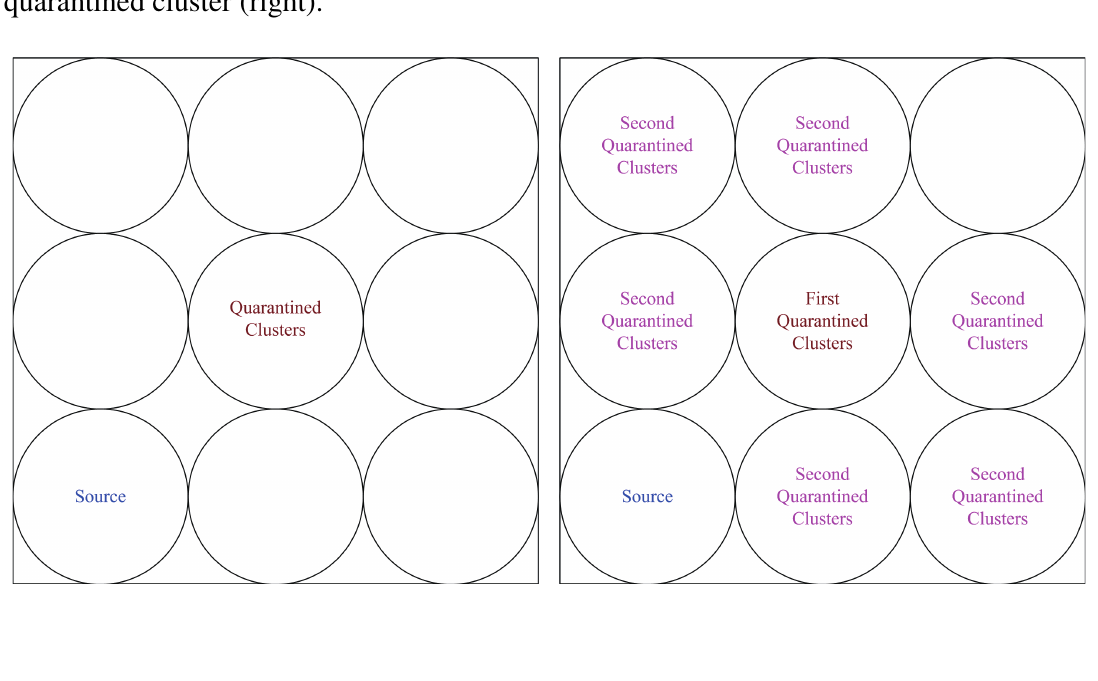
Figure 8. The locations of quarantined clusters given the location of source group 1; one cluster quarantined (left), two clusters quarantined with possible locations of the second quarantined cluster (right).